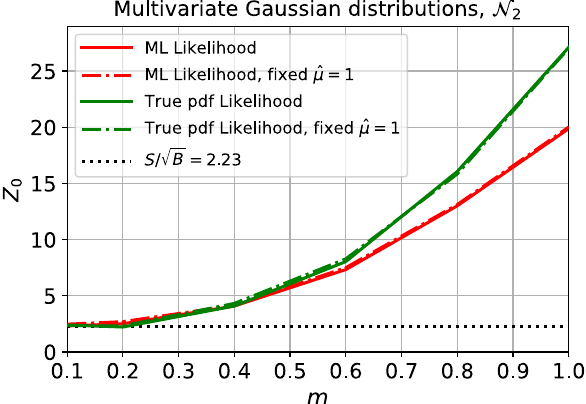
Fig. 5 Discovery significance calculated with various methods for the same multivariate Gaussian example used in Fig. 4, increasing signal- background separation m , and fixed (cid:8) B (cid:9) = 50k and (cid:8) S (cid:9) = 500. We compare the results when computing ˆ μ numerically from data (solid) with those obtained after the approximation ˆ μ = 1 (dot-dashed).